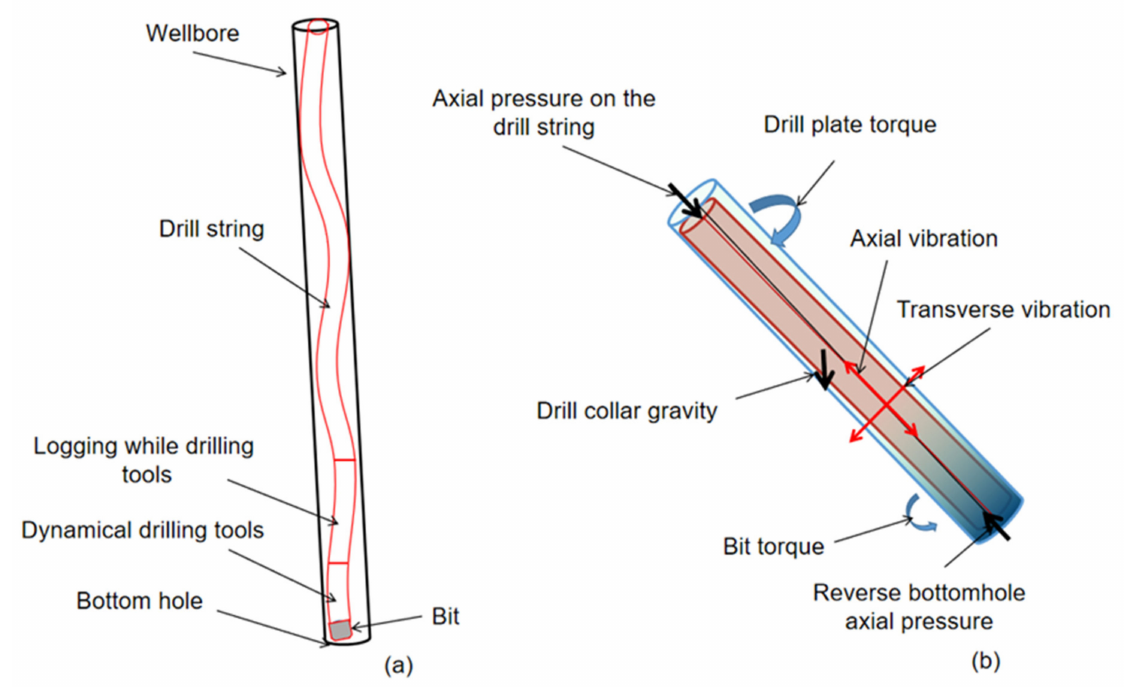
Figure 1. ( a ) Position and force of drill collars while drilling in the wellbore; ( b ) Schematic diagram of drill collar force.